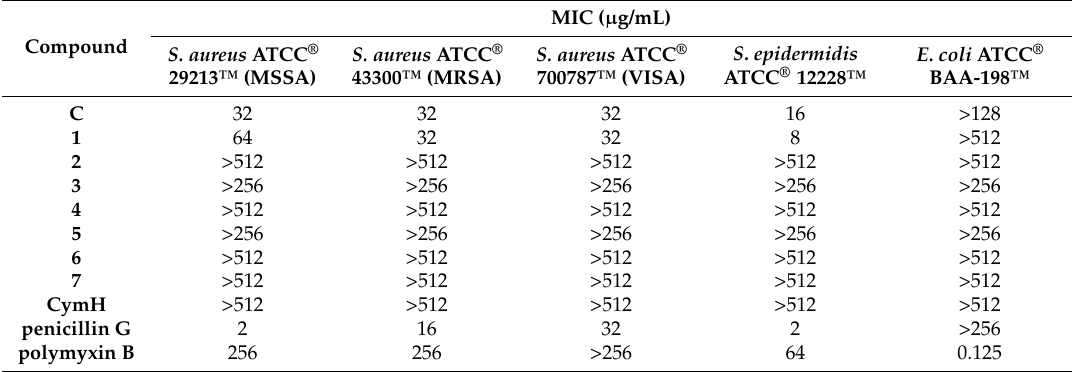
Table 3. In vitro antibacterial activity of complexes 1 – 6 , C , and the 7 , CymH compounds against reference bacterial strains (MIC µ g/mL) a .